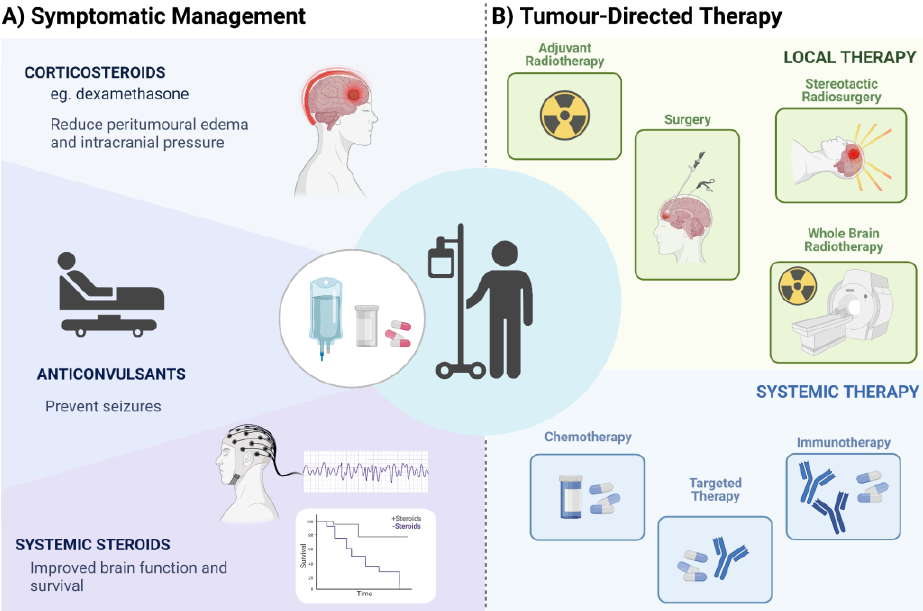
Figure 4. Summary of different strategies for the treatment of patients with brain metastasis including symptomatic management and tumor-directed therapies.